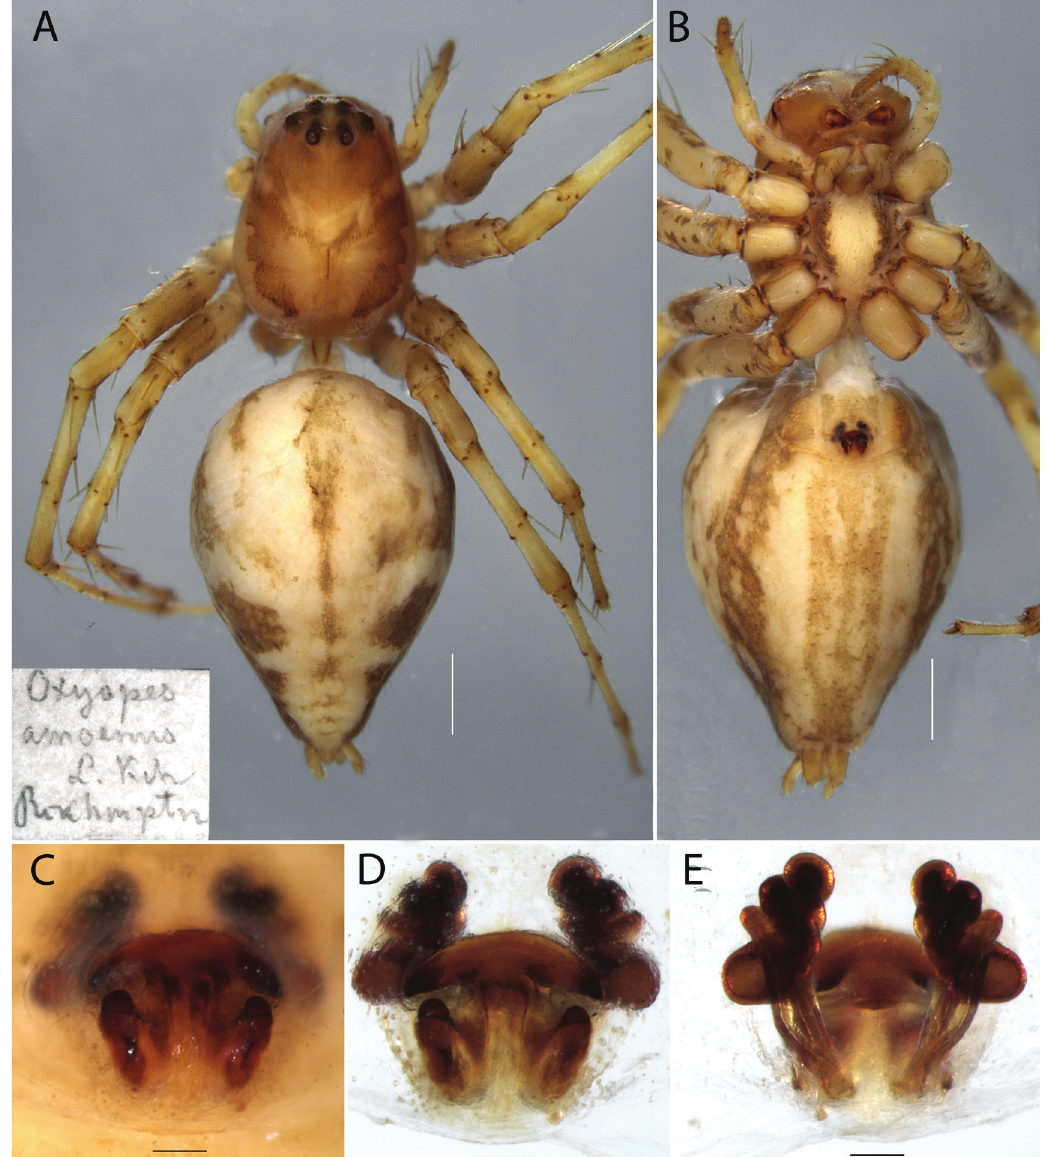
Figure 4. Oxyopes amoenus L. Koch, 1878, female syntype ( ZMH- A0000003): A , habitus, dorsal view; B , habitus, ventral view; C , epigyne, ventral view; D, epigyne, ventral view, cleared; E , epigyne, dorsal view, cleared. Scale bars: habitus 1.0 mm, epigyne 0.1 mm .